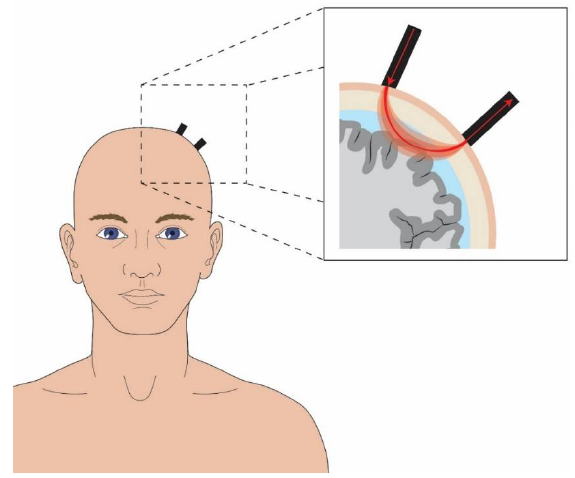
Figure 1 . Representation of the photon banana: On the left, an emitter and a detector of near-infrared light are represented placed on the scalp. On the right: A coronal section of the cranium shows the photon banana between the probes. The light emitted passes through the extra-cranial tissue, the bone, the cerebral-spinal fluid and the surface of the brain. It should be noted that the amount of light scattered increases with the depth of the photon banana.